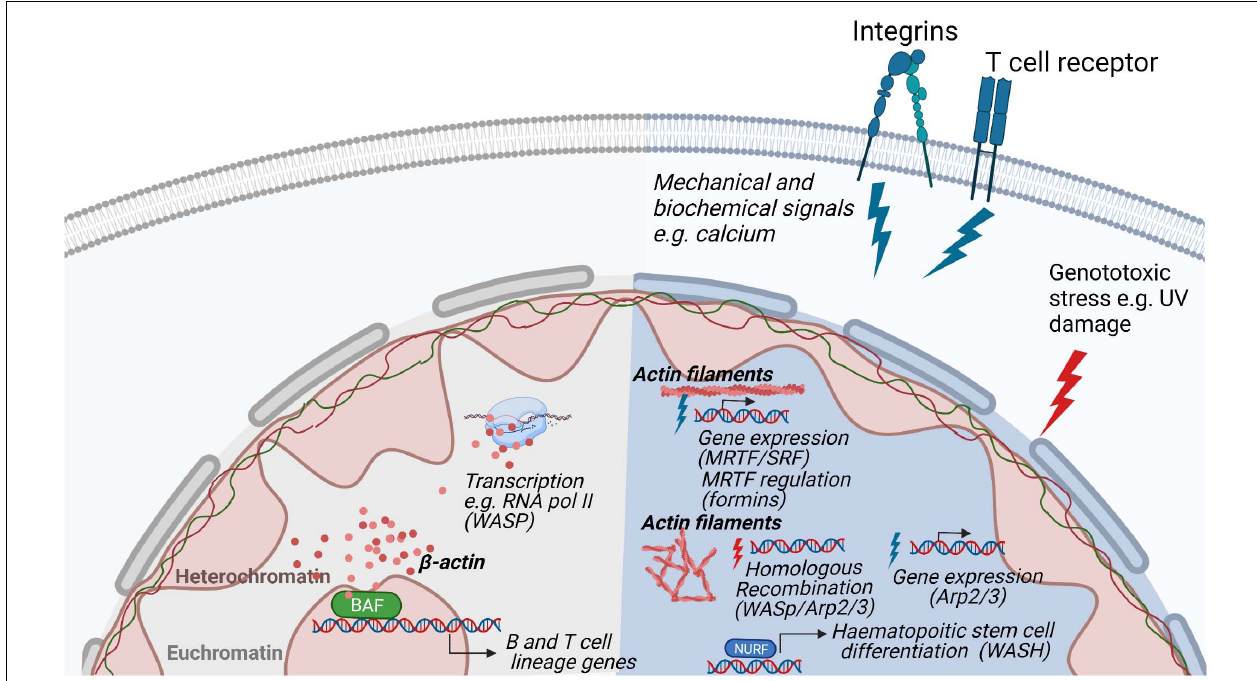
FIGURE 5 | Regulation of nuclear functions by the actin cytoskeleton . Nuclear actin plays a role in genome organization and associates and with the transcription machinery. In hematopoietic cells, the actin based chromatin remodeller BAF is involved in the development of B- and T lymphocytes lineages. In response to stimulation, polymerization of actin filaments through various biochemical pathways regulate gene expression and nuclear damage responses. During homologous recombination, WASp, Arp2/3 and actin polymerization promote the movement of DNA damaged foci to the nuclear lamina for repair. In T cells, WASp is involved in RNA Pol II dependent transcription of T cell development genes and it absence results in a decreased of RNA pol II